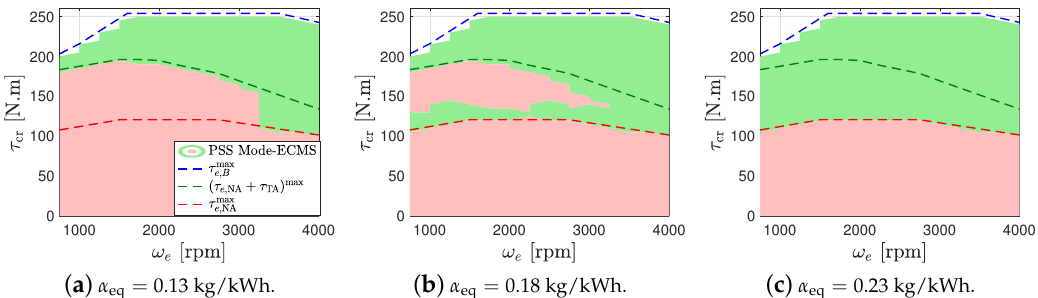
Figure 6. Equivalent consumption minimization strategy (ECMS)-generated PSS mode for different equivalence factors. The green color represents boosting mode, and the red color indicates torque assist mode. ( a ) α eq = 0.13 kg/kWh, ( b ) α eq = 0.18 kg/kWh, and ( c ) α eq = 0.23 kg/kWh. Increasing the equivalence factor shifts the optimal strategy from torque assist to favor boosting